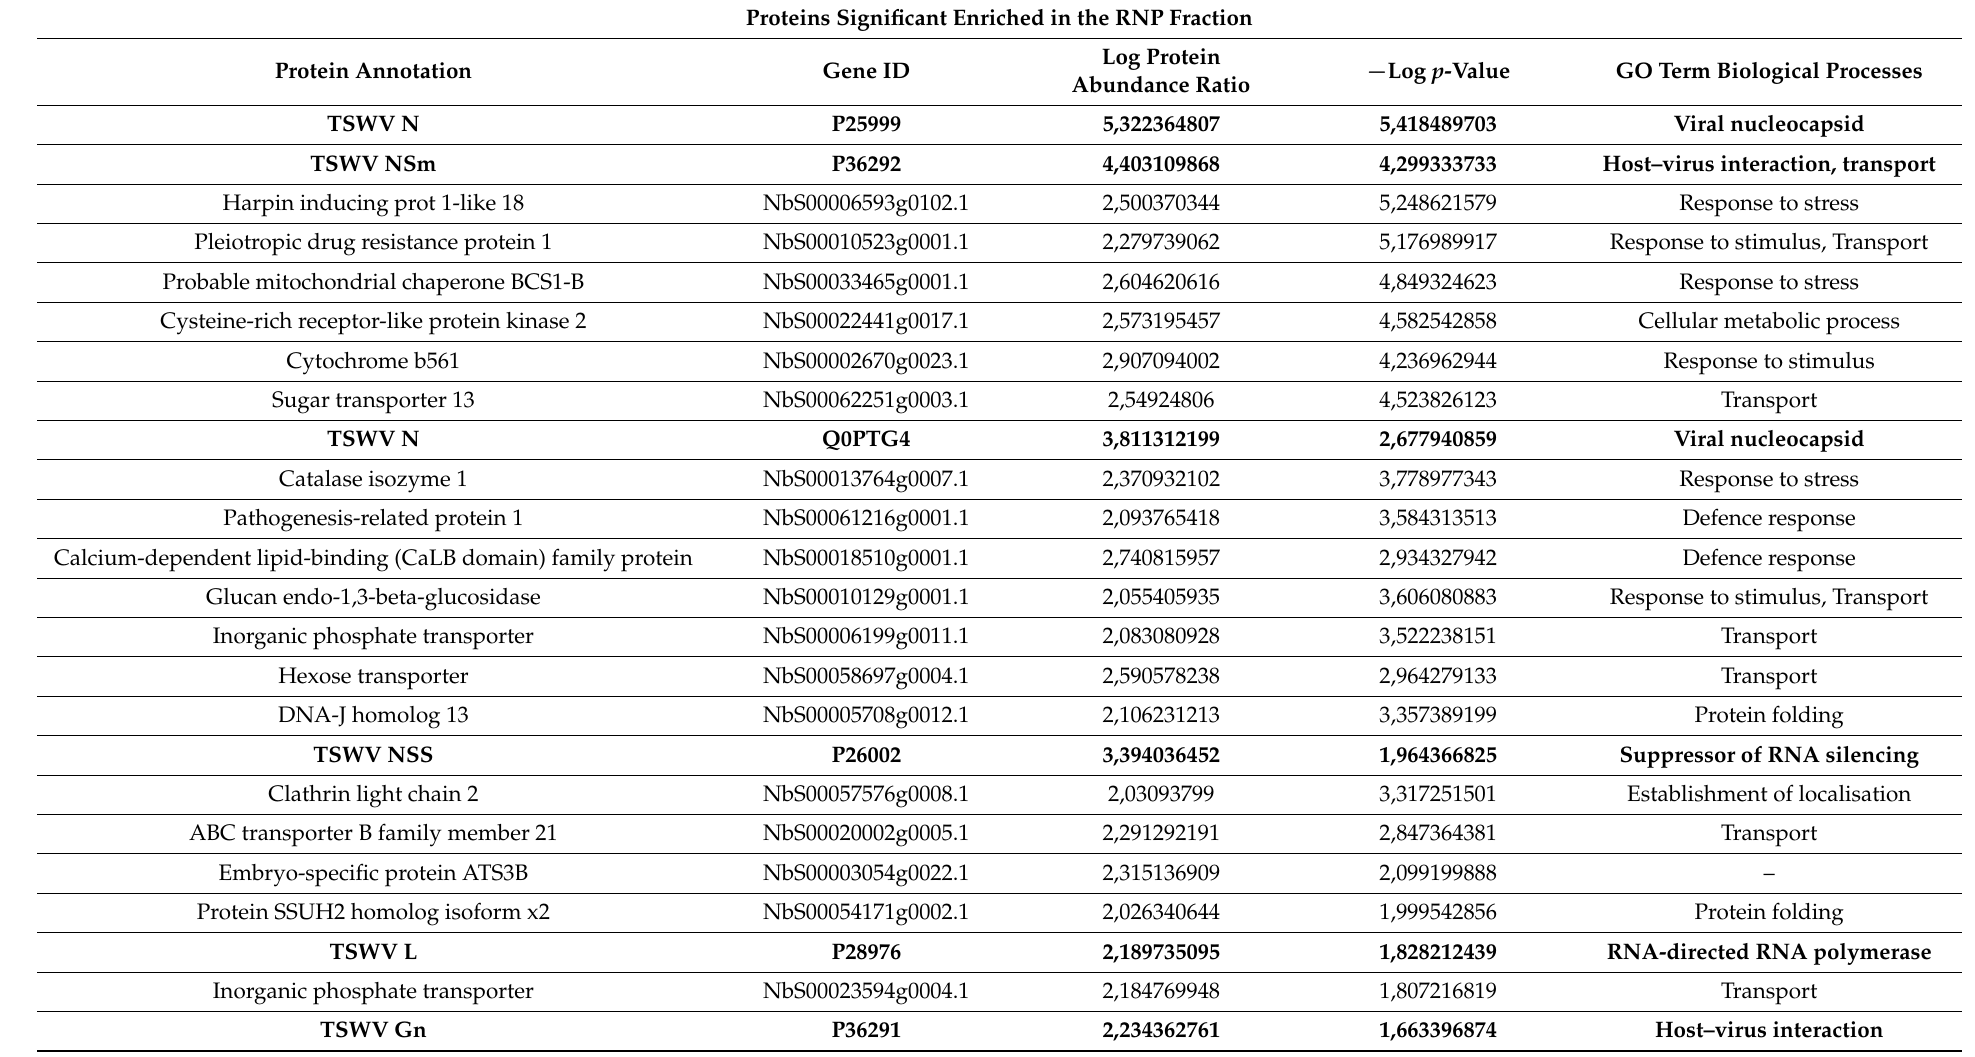
Table 1. List of protein either enriched in the RNP fraction or the mock fraction. Proteins in bold are TSWV proteins. Proteins Significant Enriched in the RNP